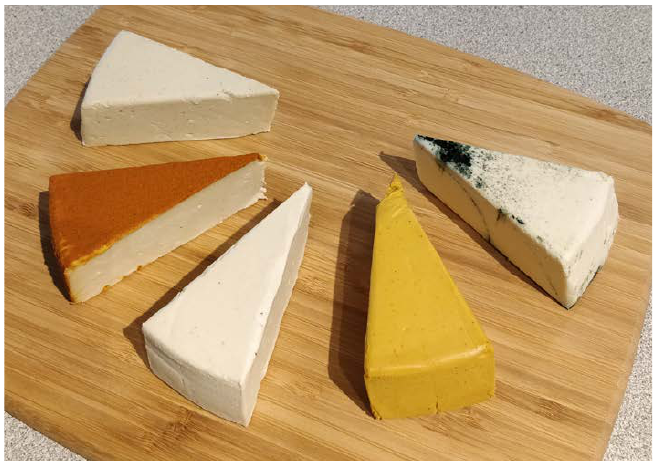
Figure 1. Five flavours of fermented cashew product. From left to right: ‘brie’, red, herb, ‘cheddar’, and ‘blue’ cashew cheese-like product.